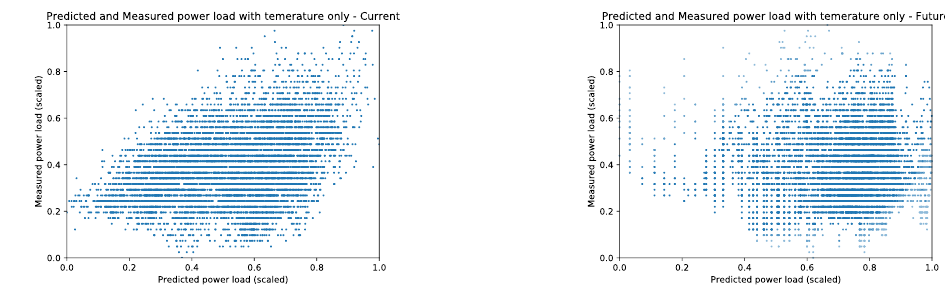
Figure 8. The power load predictions results using only the temperature weather conditions. ( Left ) Predicted power load using the current temperature conditions with the MSE = 1.20 × 10 − 2 . ( Right ) Predicted power load using the future LSTM temperature predictions with the MSE = 1.66 × 10 − 2